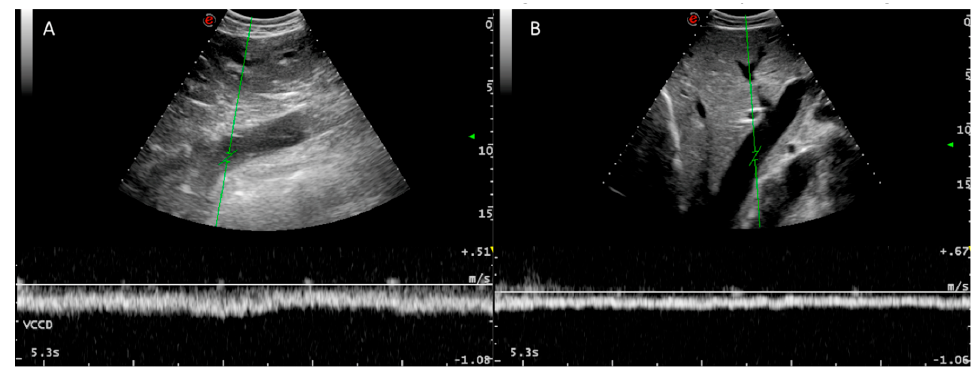
Figure 6. Doppler spectra of the caudal vena cava ( A ) and a hepatic vein ( B ). A typical laminar venous flow can be observed in both cases. Table 5. Results of ultrasonography examination of the caudal vena cava expressed as mean (95% CI) and median (minimum–maximum). Values obtained in the most frequent location are highlighted in bold. Location Flank 12 ICS 11 ICS 10 ICS 9 ICS No. of observations (no. cows) General